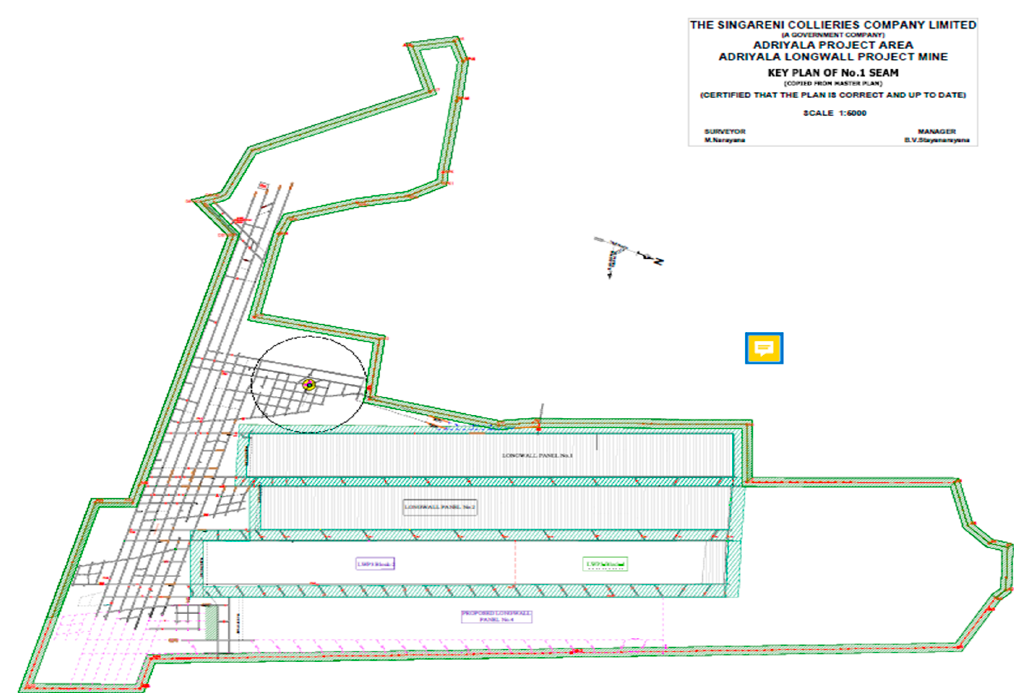
Figure 9. Diagram showing plan of longwall panels of ALP mine (SCCL). Table 5. The geotechnical parameters of No. 1 seam and its overlying roof strata of the ALP Mine. Bed No.